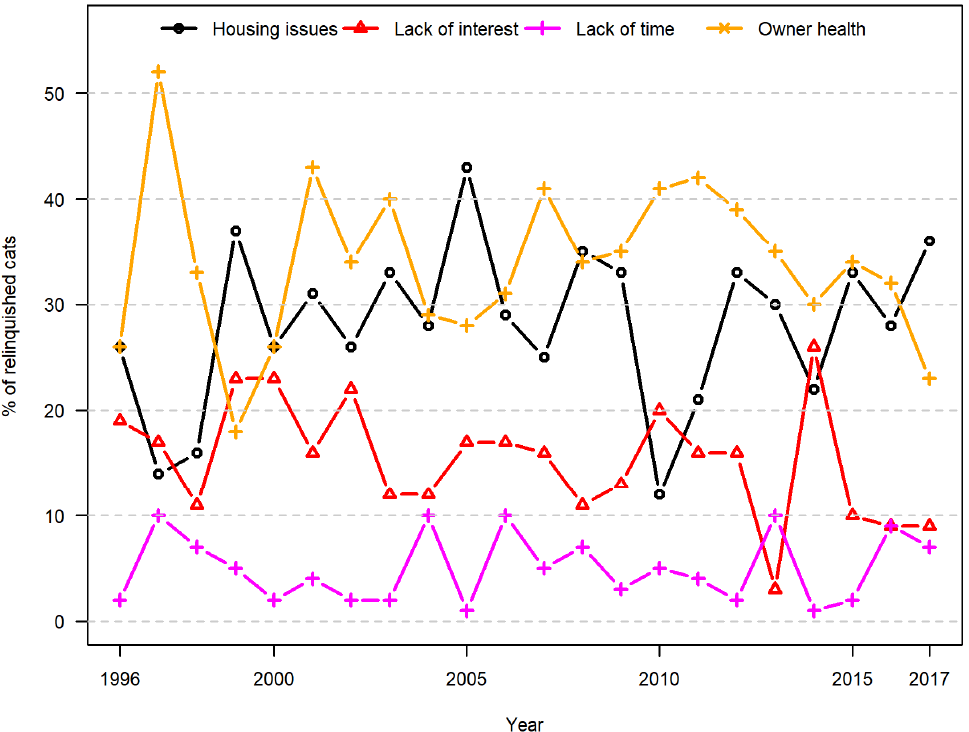
Figure 6. Owner-related reasons for relinquishment (cats). Proportional distribution of reported owner-related reasons for the relinquishment of cats in a Danish animal shelter from 1996 to 2017.